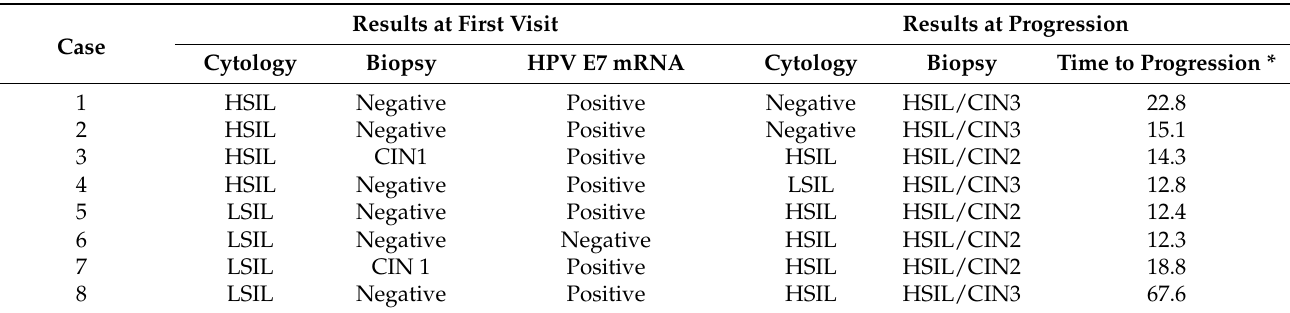
Table 4. Clinical characteristics of the eight women who progressed to high-grade squamous in Table 2. Or cervical carcinoma (HSIL/CIN2+) during